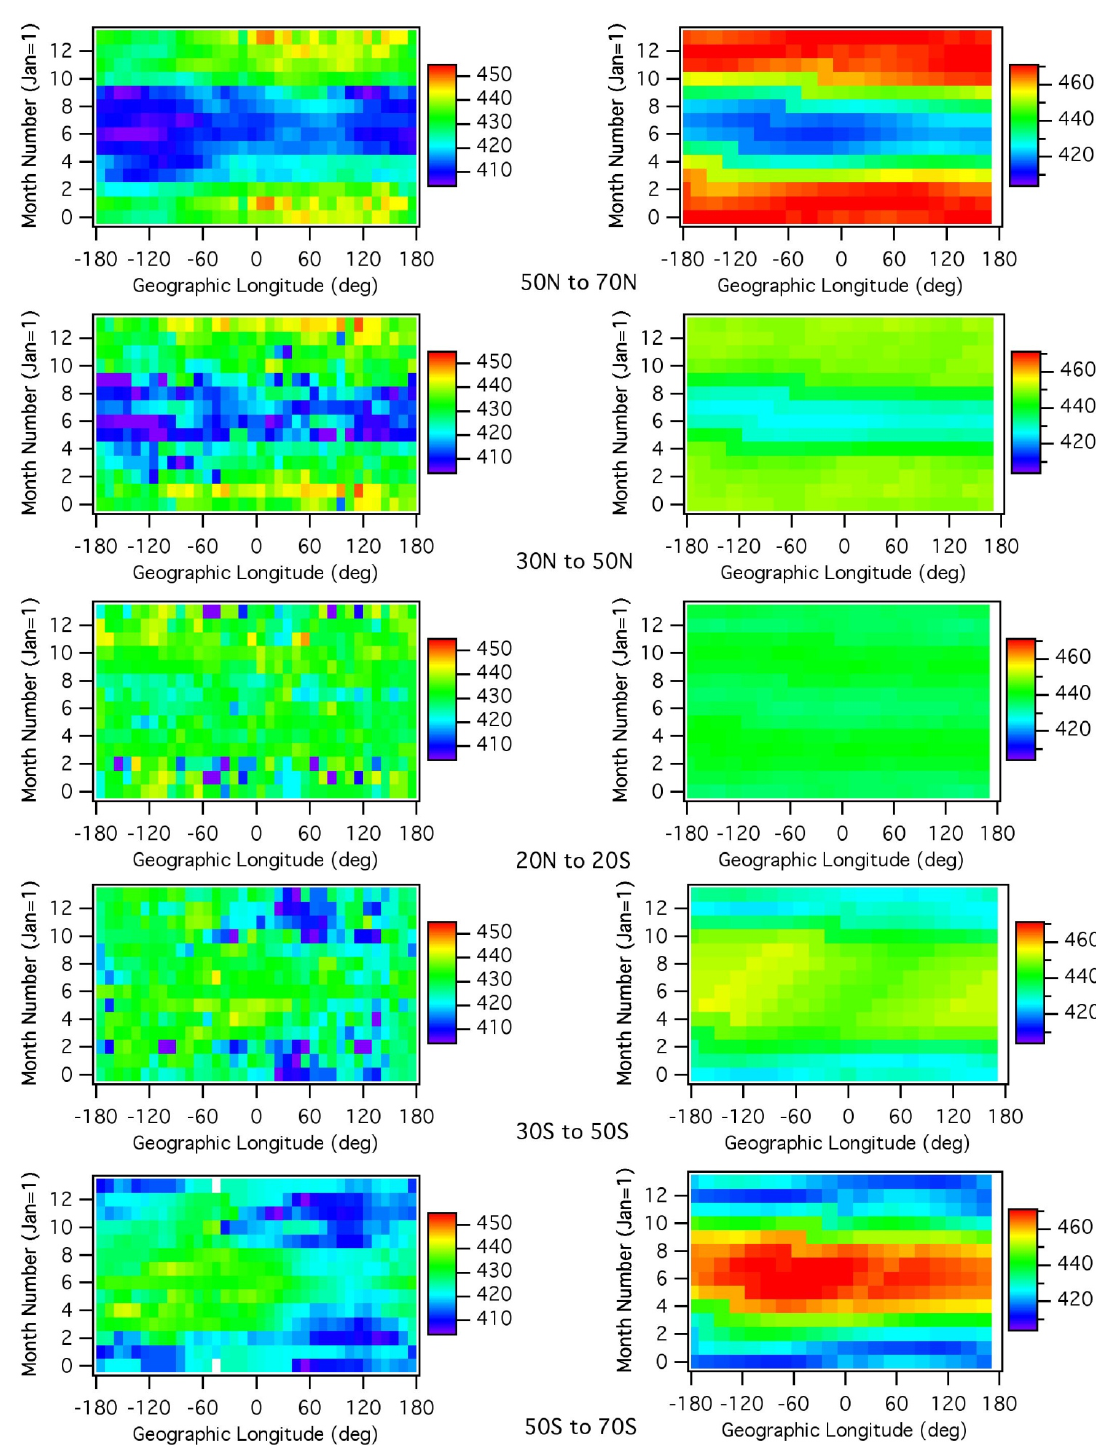
Fig. 6. P -parameter from AE-C data (left) and CTIP (right) vs. month and longitude for K p ≤ 3, for five ranges of geographic latitude. Top to bottom: 50–70 ◦ N, 30–50 ◦ N, 20 ◦ S to 20 ◦ N, 30–50 ◦ S, 50–70 ◦